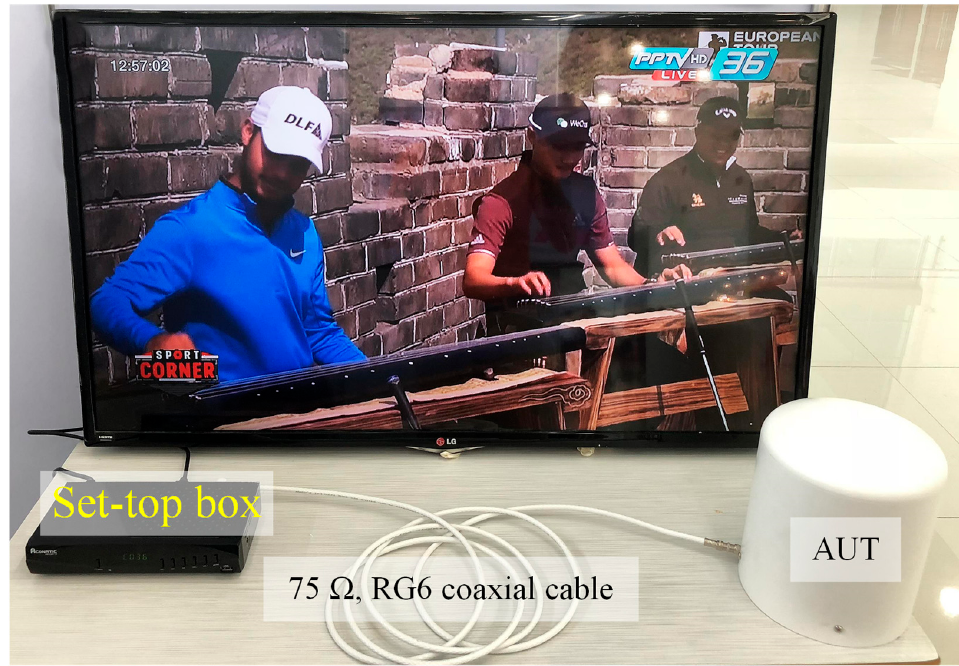
Figure 24. The experimental setup for the reception test in actual use.